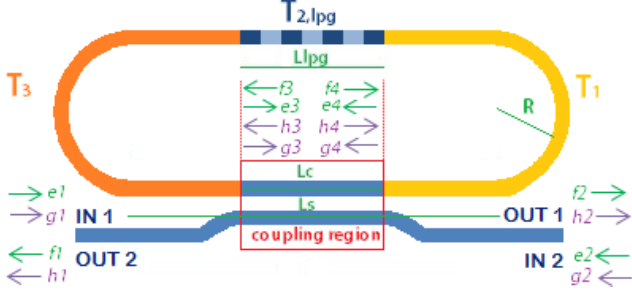
Figure 3. Generic 4-port scheme of LPGRR subdivided in elementary sections to derive the total transfer matrix as the product of individual matrices with core (green) and cladding (violet) fields directed according to the arrows’ directions.